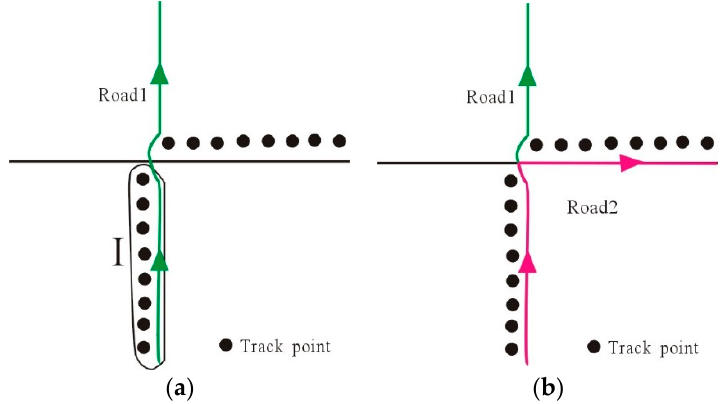
Figure 2. ( a ) Global Positioning System (GPS) track; ( b ) track point matching.